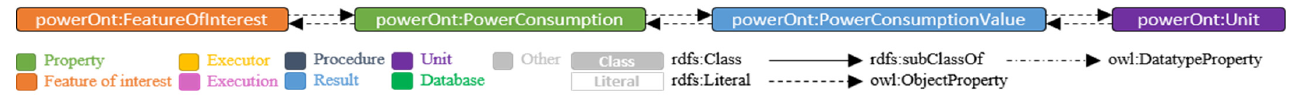
Figure 12. Linking the property (PowerConsumption) and result (PowerConsumptionValue) class using PowerOnt.